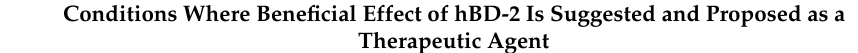
Table 1. Diseases in which hBD-2 may induce beneficial effects.